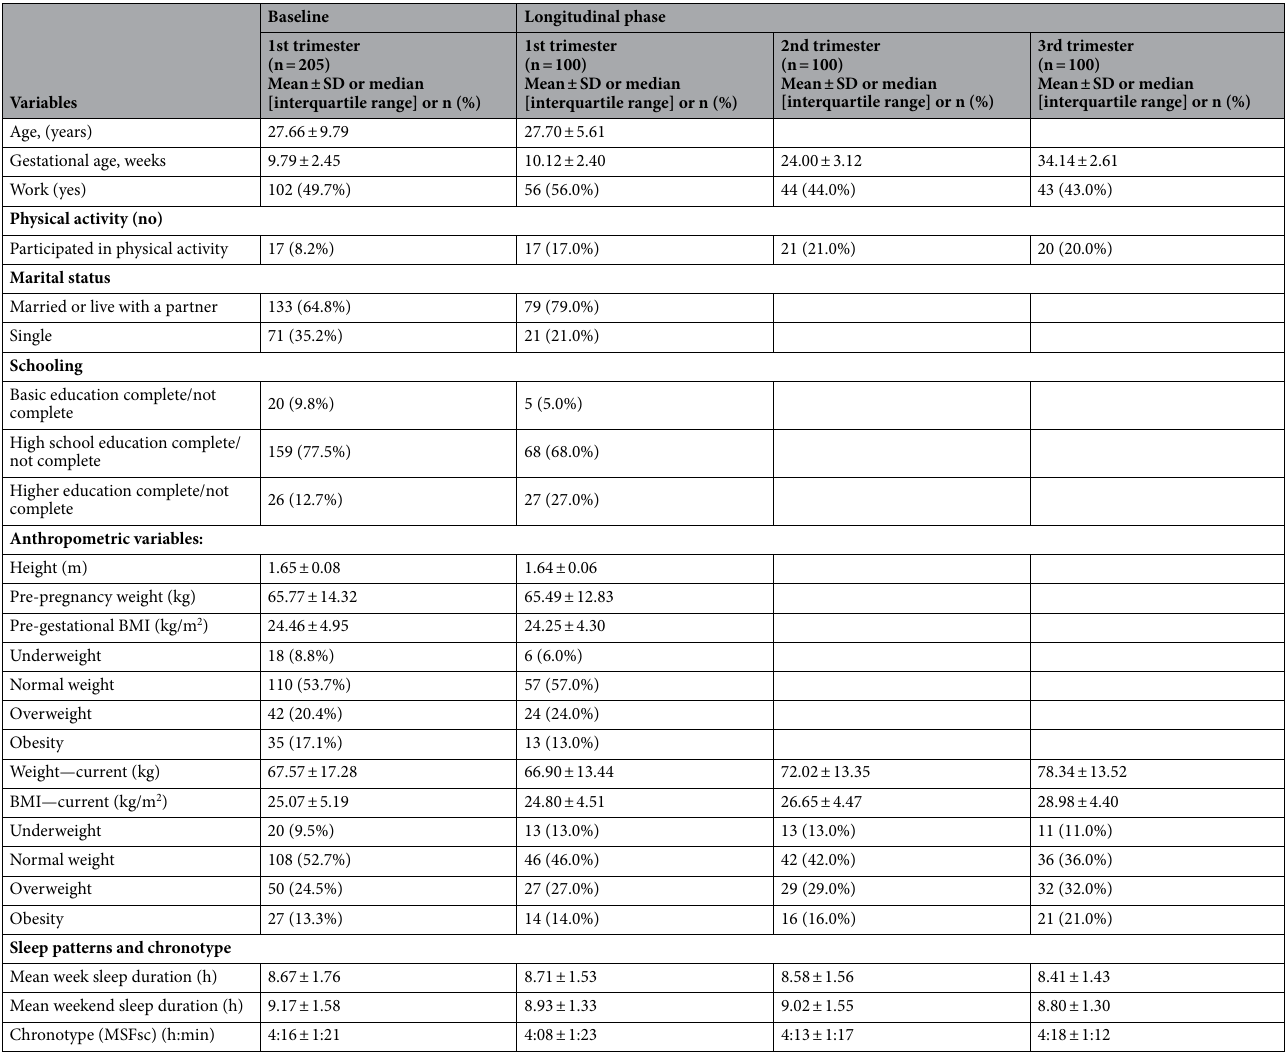
Table 1. Socio-demographic data, lifestyle, anthropometry, sleep patterns and chronotype of all pregnant women in the baseline and the women followed in the longitudinal phase. BMI body mass index; MSFsc midsleep phase on free days corrected for sleep debt on work days. Values are presented as mean and SD (standard deviation) for normally distributed data or as median [interquartile range] for not normal distributed data or n